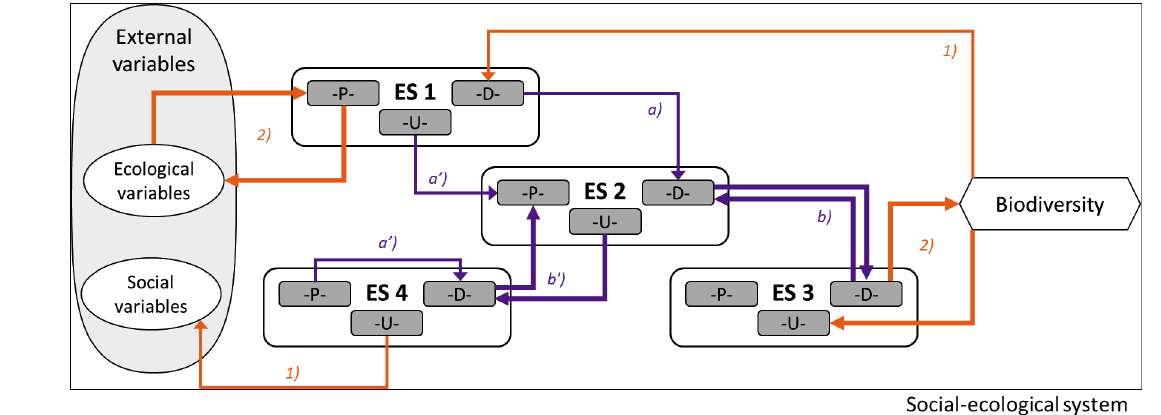
Fig. 1 . Influence network framework (INF). The INF describes influence relations between ecosystem services (ES), biodiversity, and external ecological and social variables, within the social-ecological system. Ecosystem services are described explicitly by their three facets: potential supply (-P-), demand (-D-), and use (-U-). Influence relationships are unilateral when one variable influences a second one without major feedback (thin arrows) and mutual when both variables influence each other (bold arrows). Relationships occur between ES (purple arrows), either among the same facets (a, b) or among distinct facets (a’, b’). Interactions among differing facets of the same ES can also occur (a’). Relationships additionally connect ES facets and other variables (orange arrows) with a unilateral influence (1) or mutual influences (2). External variables and biodiversity can similarly interact through unilateral or mutual influences (arrows not shown). All relations can be positive, negative, or of varying influence.